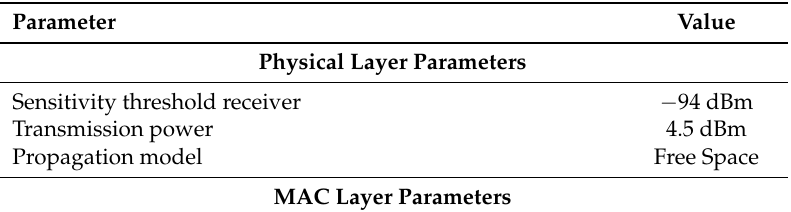
Table 1. Simulation and real network parameters. CSMA/CA, carrier sense multiple access with collision avoidance